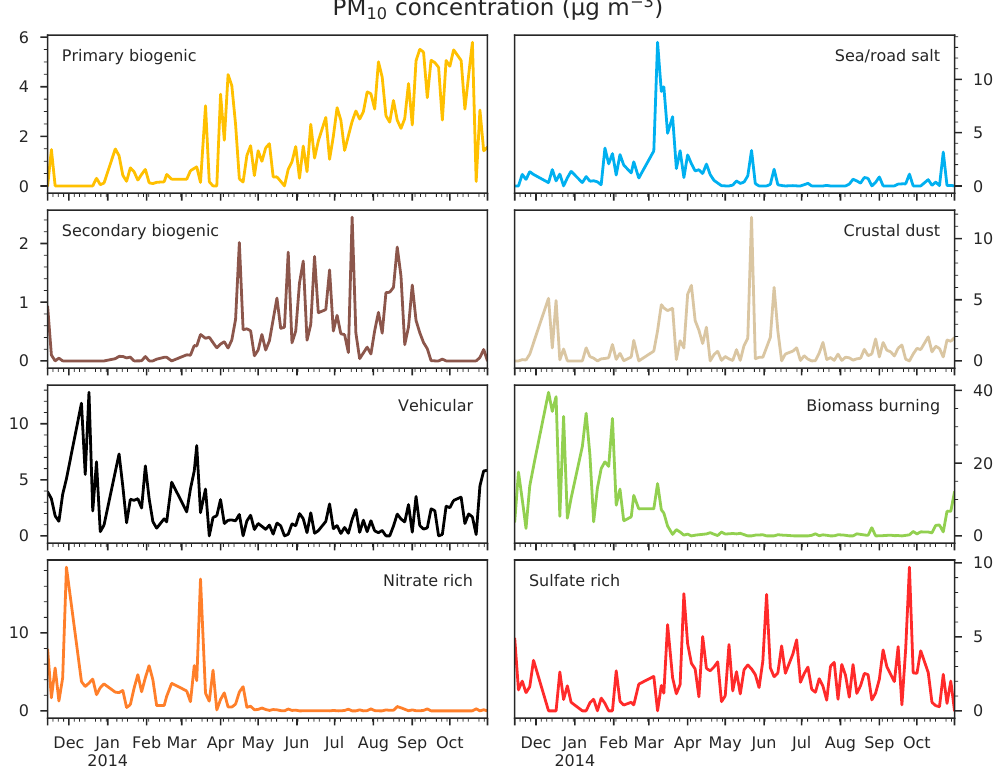
Figure 3. Mass concentrations of the eight PMF sources as fractions of PM 10 from 14 November 2013 to 31 October 2014 (107 samples) at the Chamonix station. Units are expressed in µgm − 3 . Note the different scales on the source